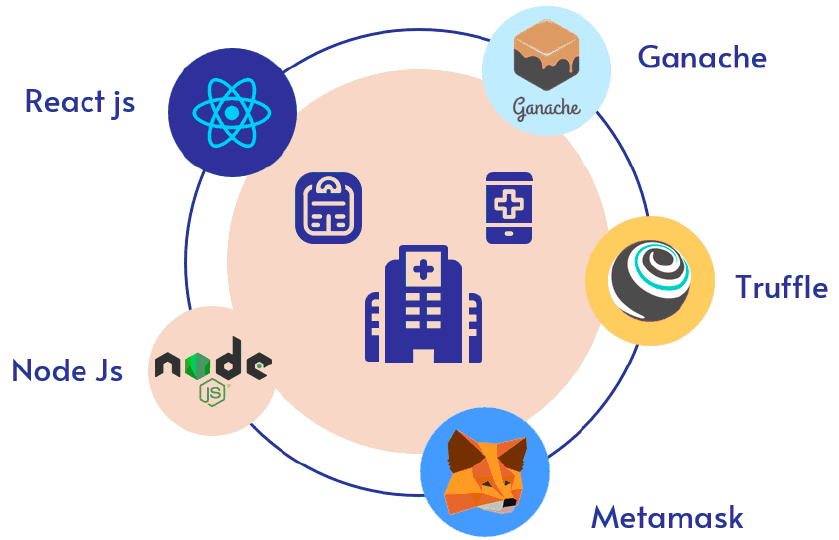
Figure 8. Used SW Figure 8. Used SW applications.